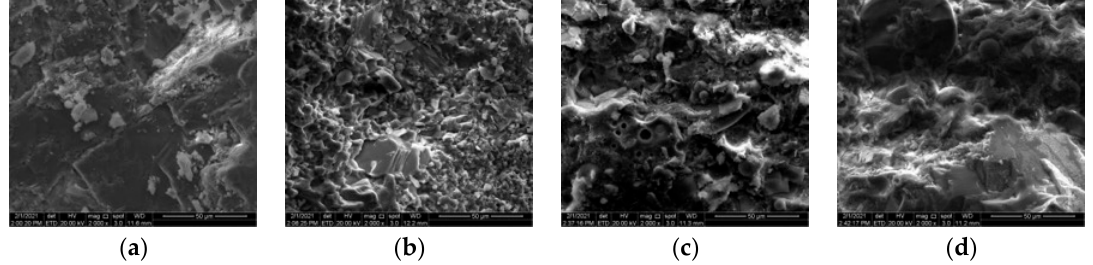
Figure 8. Section SEM images of SFSCC at 1 year. ( a ) SFSCC-0 (2000×); ( b )SFSCC-40 (2000×); ( c ) SFSCC-50 (2000×); ( d ) SFSCC-60 (2000×).